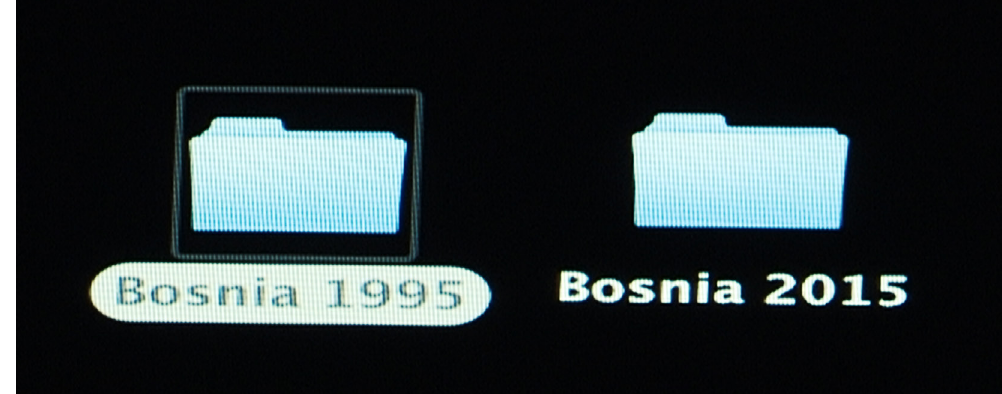
Fig. 3. Still from the documentary-poetry film Bridges <Bosnia 20>